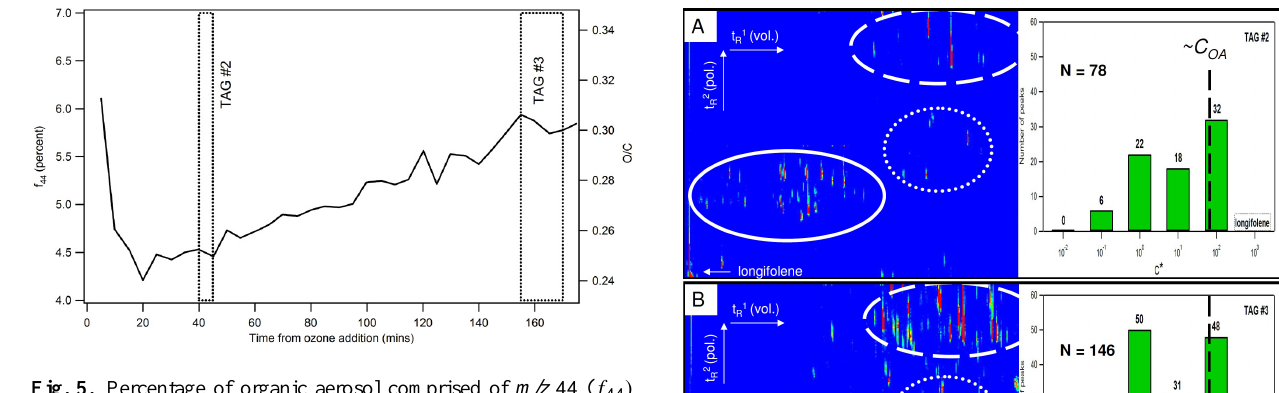
Fig. 5. Percentage of organic aerosol comprised of m/z 44 ( f 44 ) over the course of the longifolene ozonolysis. O/C is estimated from this value using the correlation reported by Aiken et al. (2008).